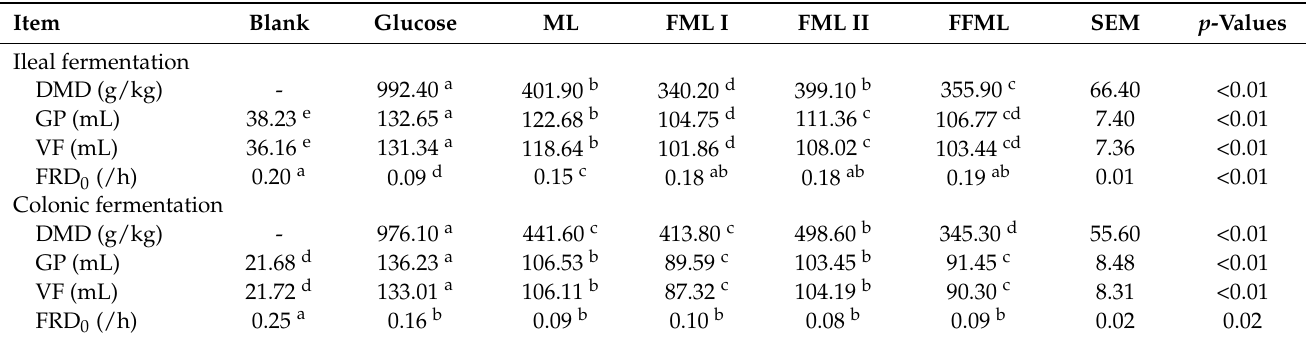
Table 5. In vitro dry matter degradation (DMD) and gas production parameters of Mao-tai lees and fermented Mao-tai lees in the ileum and colon.